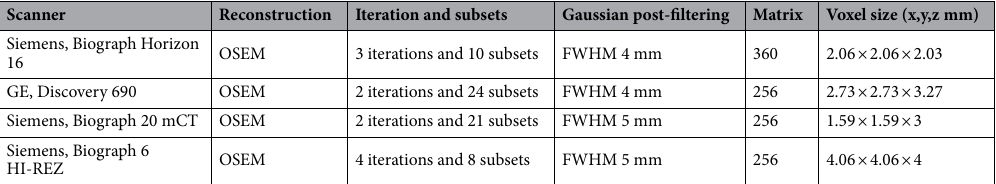
Table 1. Image reconstruction parameters for all four different PET systems. OSEM ordered subsets expectation maximization, FWHM full width at half